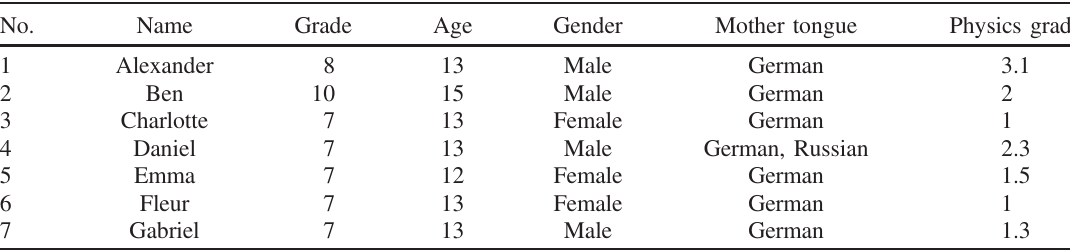
TABLE VI. Demographic and other background data about the students participating in the interviews (the physics grade is reported on the scale of 1 ¼ very good to 6 ¼ insufficient ). Students ’ names were changed for reasons of data